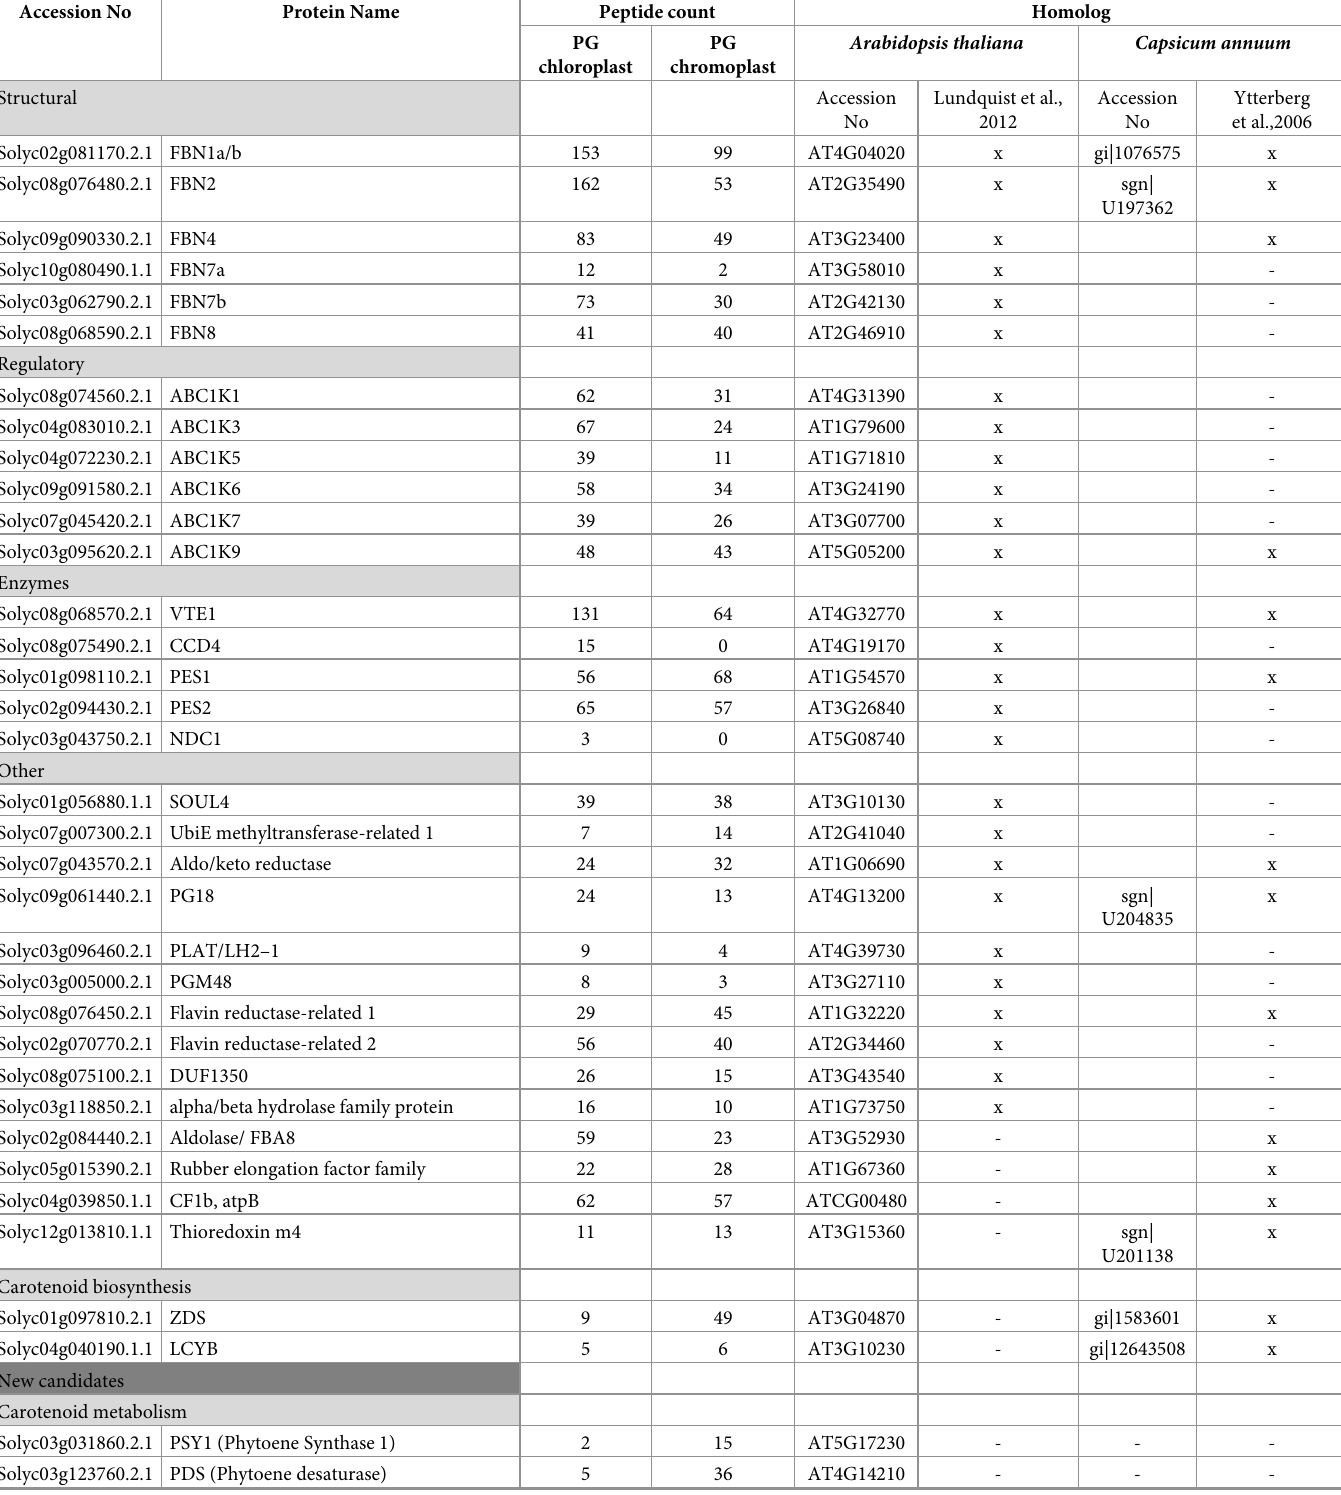
Table 1. Proteome of tomato fruit chloroplast and chromoplast